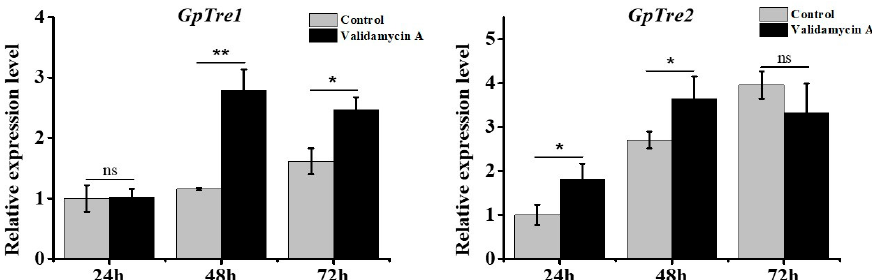
Figure 7. Changes in the expression levels of GpTre1 and GpTre2 at different times after injection with Validamycin A. The control group was treated with ddH 2 O. Data are shown as the mean ± SE of three biological replicates. Differences between Validamycin A and control group within each time point were compared using t -test. Asterisks above the bars indicate significant differences (* p < 0.05; ** p < 0.01; ns, no significance difference).